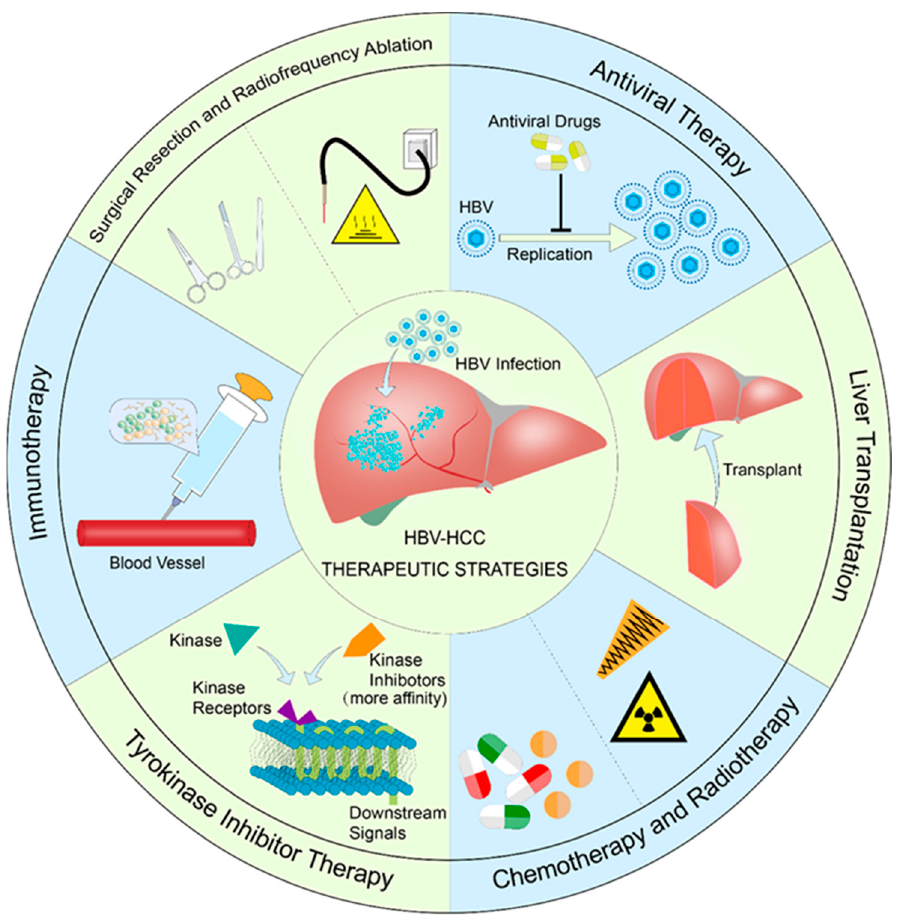
Figure 1. HBV-HCC therapeutic strategies